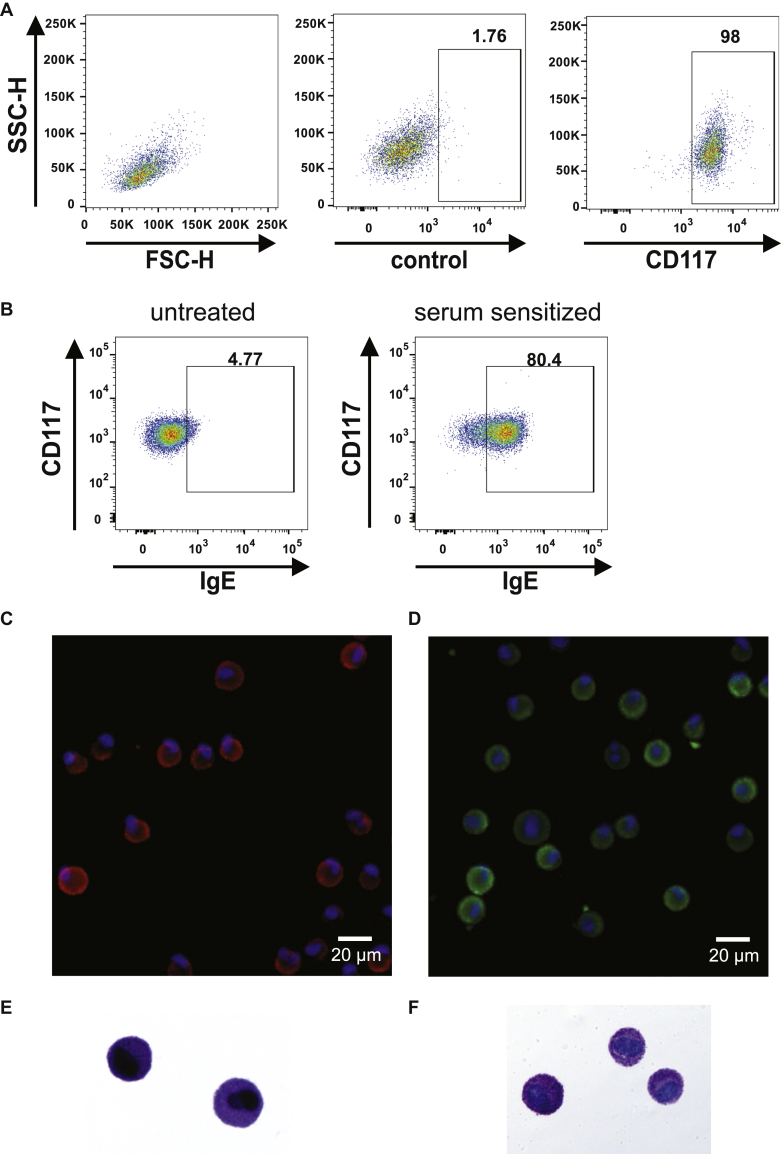
Characterization of hMCs. A, After 8 to 10 weeks of culture, hMC maturation was controlled by measuring the size granularity, (side scatter [SSC]–H/forward scatter [FSC]–H) and CD117 surface expression by using flow cytometry. Control shows fluorescence minus one values for CD117 control staining. B, Serum IgE binding. hMCs were sensitized overnight with human serum (1:10 dilution) or not for control hMCs and washed. IgE fixed on the surfaces of hMCs was detected by using flow cytometry. Numbers represent percentage cells in the gate. C and D, Immunofluorescence for tryptase (Fig E1, C) and chymase (Fig E1, D). A spectrum of tryptase and chymase expression is seen within the MC population. E and F, MC metachromatic granules were identified by using May-Grünwald Giemsa (Fig E1, E) or toluidine blue (Fig E1, F) staining.